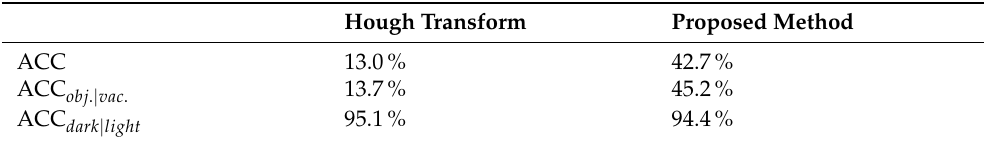
Table 2. Comparison of proposed method and Hough transform, with respect to their overall accuracy ACC, object vs. vacancy accuracy ACC obj . | vac . and dark vs. light accuracy ACC dark | light . Hough Transform Proposed Method ACC 13.0% 42.7% ACC obj . | vac . 13.7% 45.2% ACC dark | light 95.1%